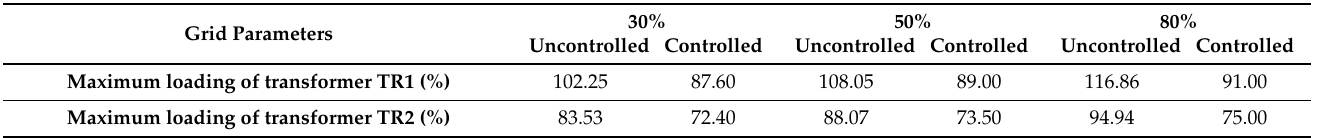
Table 2. Comparison of transformer loading for the controlled and uncontrolled charging